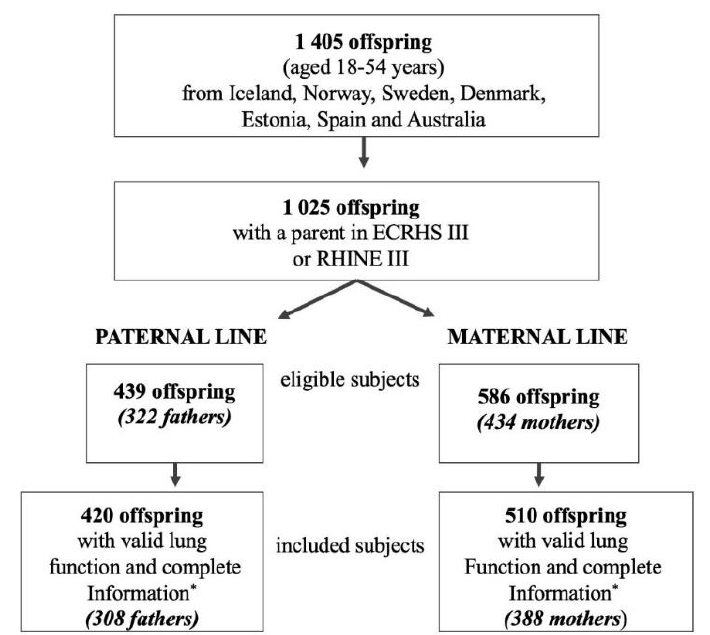
Figure 1. Study population RHINESSA clinical-stage flow chart. * Offspring with information on their own body silhouette and height and on body silhouettes of their participating parent.